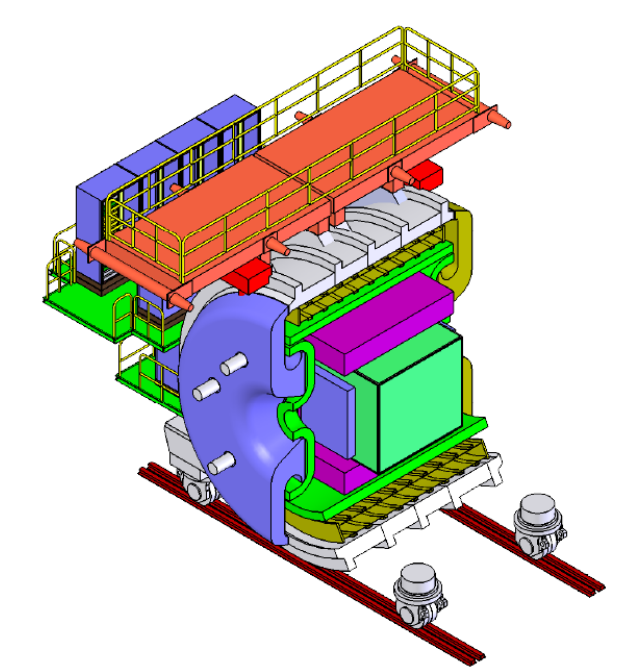
Figure 115. Drawing of the SAND system showing 3DST+TPCs configuration with the 3DST in the center (light green), low-density tracker (TPC or STT, Magenta), ECAL (green), the magnet coil (gold), and the return yoke (gray). For scale, the magnet center is 4.2 m off the floor and the width of the walkway on the top is 9.9